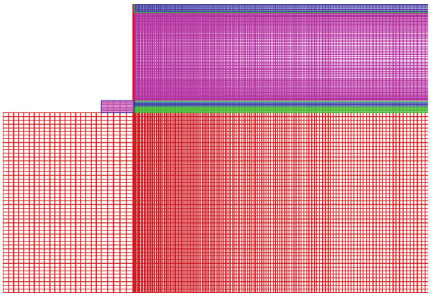
Figure 4: Computational grids.